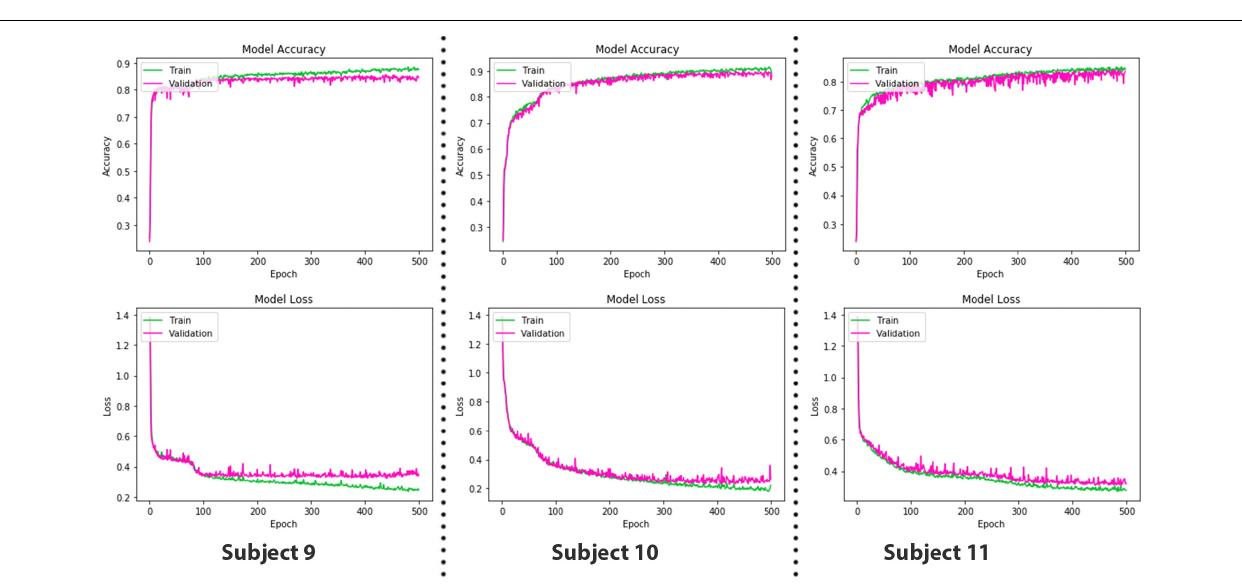
FIGURE 10 | The epoch versus accuracy and loss plots of long short-term memory (LSTM) on train and validation datasets.